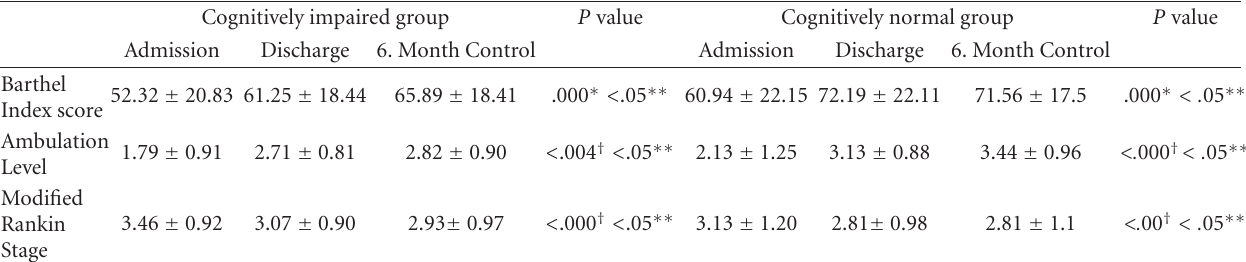
Table 3: Barthel Index scores, ambulation levels and Modified Rankin Stages of the study groups.